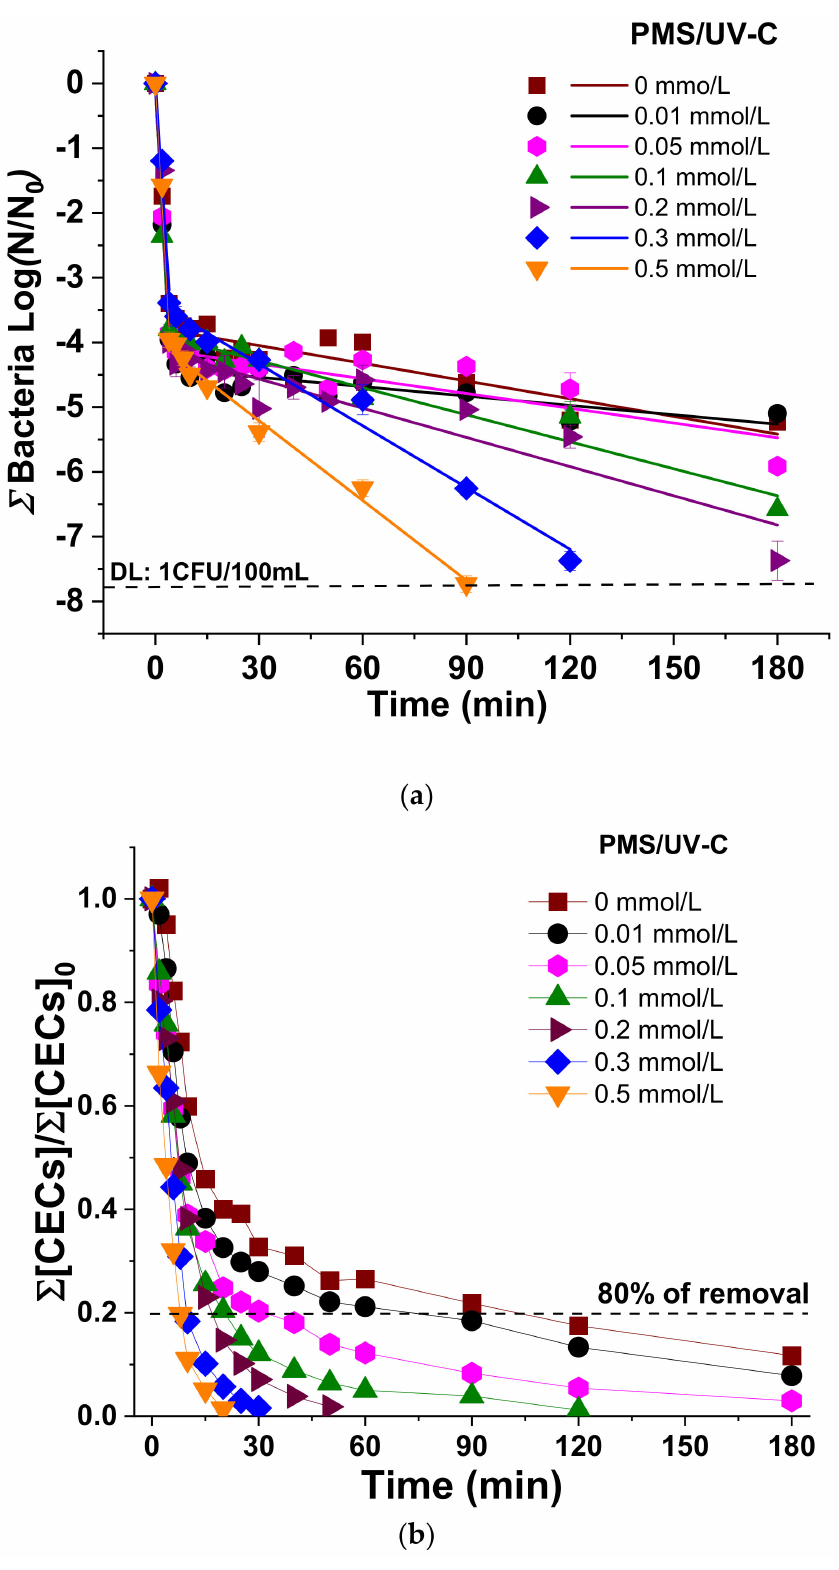
Figure 1. ( a ) Linear fitting of total bacteria inactivation; ( b ) Degradation of total CECs in SUWW under UV-C irradiation in the presence of increasing concentration of PMS (0–0.5